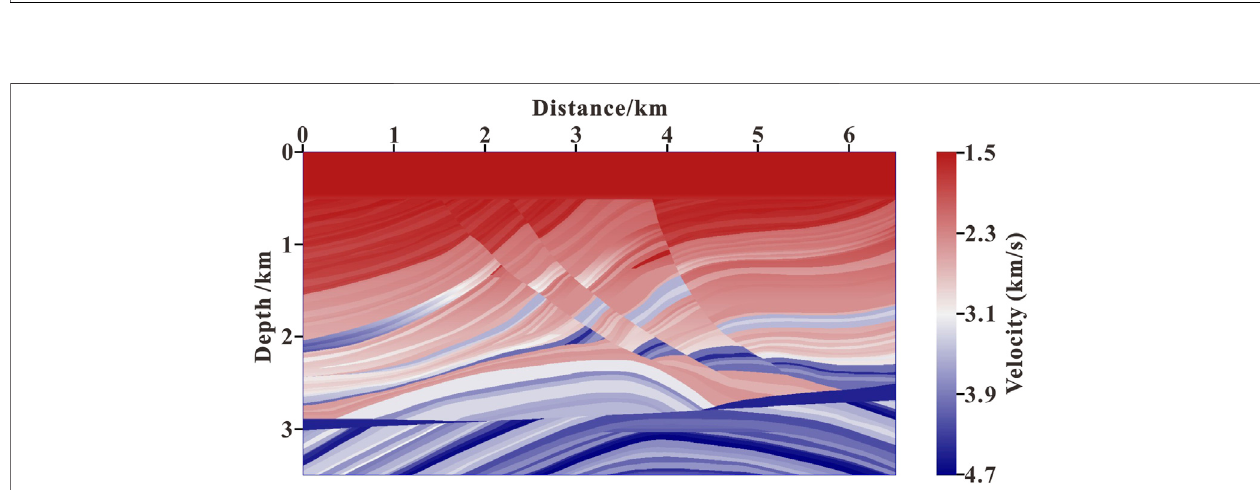
FIGURE 6 | The imaging result of RTM: (A) conventional RTM; (B) RTM with wave fi eld decomposition based on the Poynting vector; (C) RTM with wave fi eld decomposition based on the optical fl ow vector; (D) angle-weighted RTM with wave fi eld decomposition based on the optical fl ow vector.